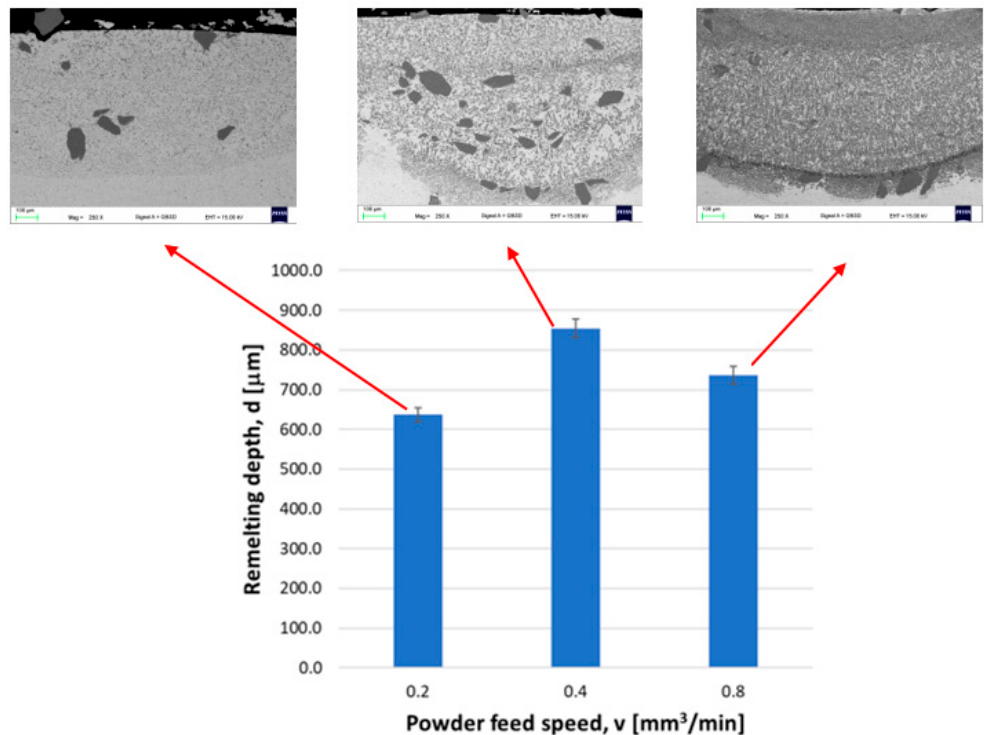
Figure 5. Effect of the powder feed rate on the thickness of the formed layer. Figure 5. E ff ect of the powder feed rate on the thickness of the formed layer.